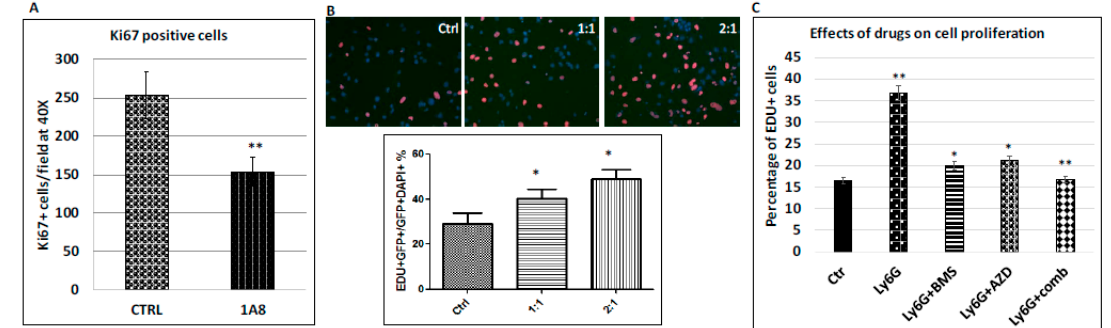
Figure 6. Regulation of cancer cell proliferation by inhibition of MEK and Hh signaling in mouse models and in cultured cells. ( A ) Expression of Ki-67 was used as the readout of cell proliferation, and percentage of Ki-67 positive cells in the metastatic cancer cells was calculated under microscope from MMC18-based model in immune competent C57/B6 mice (five mice/group), * p value < 0.05. These results are similar to those from MIA PaCa2-based model in immune deficient NSG mice (see Figure 3A); ( B ) EdU incorporation of cancer cells in the presence or absence of Ly6G + CD11b + cells in vitro. EdU incorporation of cancer cells was used to measure cell proliferation rate. With an increase in Ly6G + CD11b + cells (ratio 0:1; 1:1; 1:2 with increased number of Ly6G + CD11b + cells), EdU incorporation in the cancer cells was visualized (representative images shown above; summary from 3 independent experiments shown below), scale: 400 × ; ( C ) Effects of different compounds in reducing cell proliferation of cancer cells were assessed in vitro. Ly6G + CD11b + cells were first treated with different compounds for 2 h before adding to the top chamber. The data were from three independent experiments. * indicates significant change ( p < 0.05). While Ly6G + CD11b + cells significantly stimulated cell proliferation of cancer cells (* indicates p < 0.005), treatment with MEK inhibitor AZD6244 (or Hh signaling inhibitor BMS833923) for 2 hours before being added onto the top chamber significantly reduced cancer cell proliferation ( p < 0.05). Combination of AZD6244 with BMS833923 had a more than additive effect on cell proliferation (** indicates synergistic effect via BLISS independent analysis).